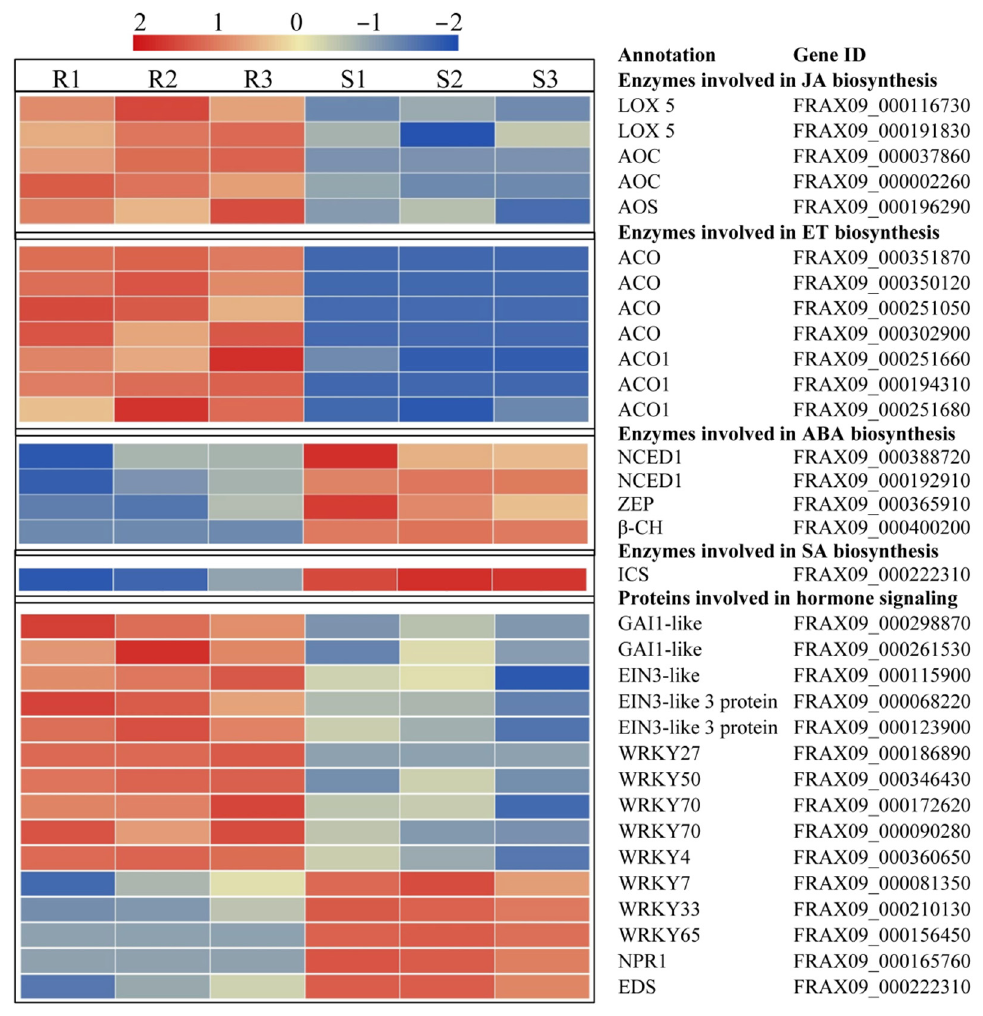
Figure 4. Heatmap of DEGs involved in phytohormone biosynthesis and signaling. R1, R2, and R3 represent three replicates of resistant F. chinensis var. rhynchophylla . S1, S2, and S3 represent three replicates of susceptible F. pennsylvanica . LOX, lipoxygenase; AOC, allene oxide cyclase; AOS, allene oxide synthase; ACO, 1-aminocy-clopropane-1-carbo- xylate oxidase; NCED, 9-cis-epoxycarotenoid dioxygenase; ZEP, zeaxanthin epoxidase; β -CH, beta-carotene hydroxylase; ICS, isochorismate synthase; EIN3-like protein, ethylene insensitive 3-like 3 protein; NPR1, nonexpressor of pathogenesis-Related protein 1; EDS, enhanced disease susceptibility.